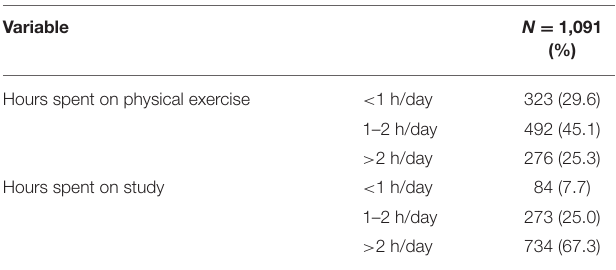
TABLE 1 | Demographics and COVID-19-related characteristics of survey